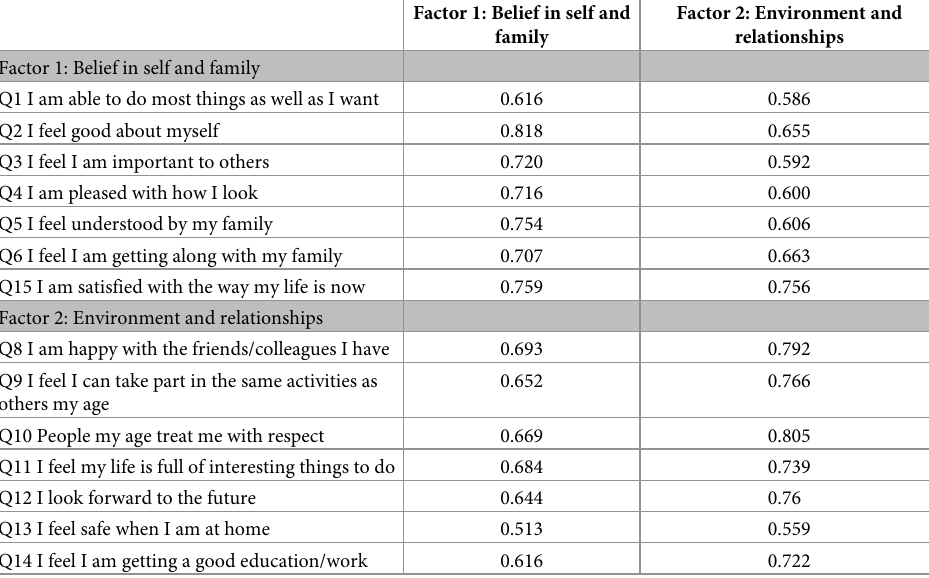
Fig 2a and 2b illustrated the factor-factor and item-item correlations. Factor 1 “Belief in self and family” was more likely to not be correlated with factor 2 “Environment and relation- ships”. Regarding item-item correlations, Q15 “I am satisfied with the way my life is now” in factor 1 correlated with Q11 “feel my life is full of interesting things to do” in factor 2. Table 4 shows that all items had correlation coefficients greater than 0.4 with their respec- tive factors’ score, indicating satisfactory convergent validity. Moreover, all items had their correlation coefficients with their factor scores greater than their correlation coefficients with other factors’ scores, implying good divergent validity. In terms of concurrent validity, Table 5 reveals the correlations between two new factors with the EQ-5D index and EQ-VAS. All correlation coefficients were statistically significant. The highest correlation coefficient was found between factor 2’s score and EQ-5D index (r = 0.4240, p < 0.05), following by factor 2’s score and EQ-VAS score (r = 0.4234, p < 0.05). Table 4. Correlation matrix between items and domain scores. Factor 1: Belief in self and Factor 2: Environment and family